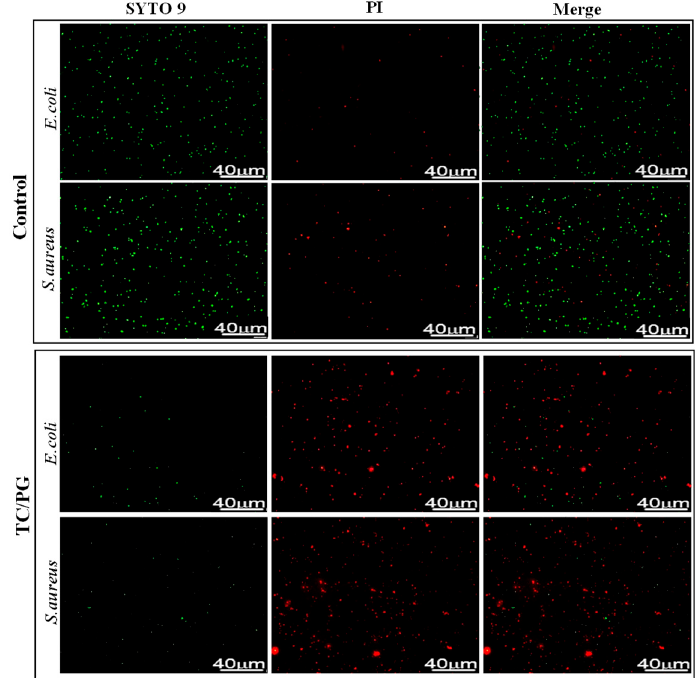
Figure 5. Images of the stained bacteria.